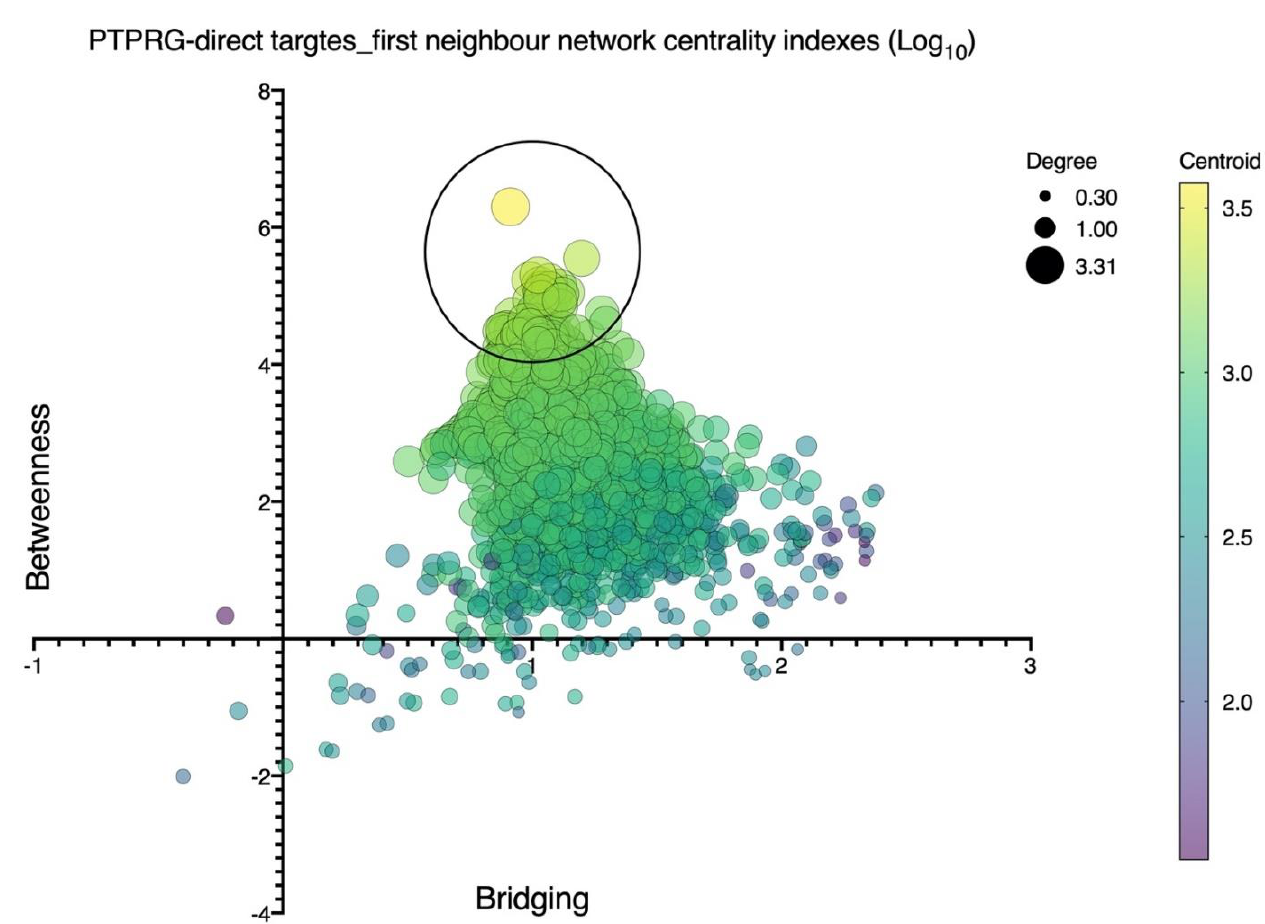
Figure 3. Node centrality index computati onal analysis of the first neighbor’s protein– protein inter- action (PPI) network inferred upon the eight known PTPRG direct targets: JAK2, BTK, ABL1, AXL, CTNNB1, BCR, EGFR, and FGFR1. Shown is multidimensional data plotting, including x – y position (betweenness and bridging), size (degree), and color (centroid). Distribution is according to these four value/nodes. The large top open circle highlights a group of nodes with higher concurrent val- ues of betweenness, centroid, degree, and bridging centralities, indicating effective information pro- cessing.